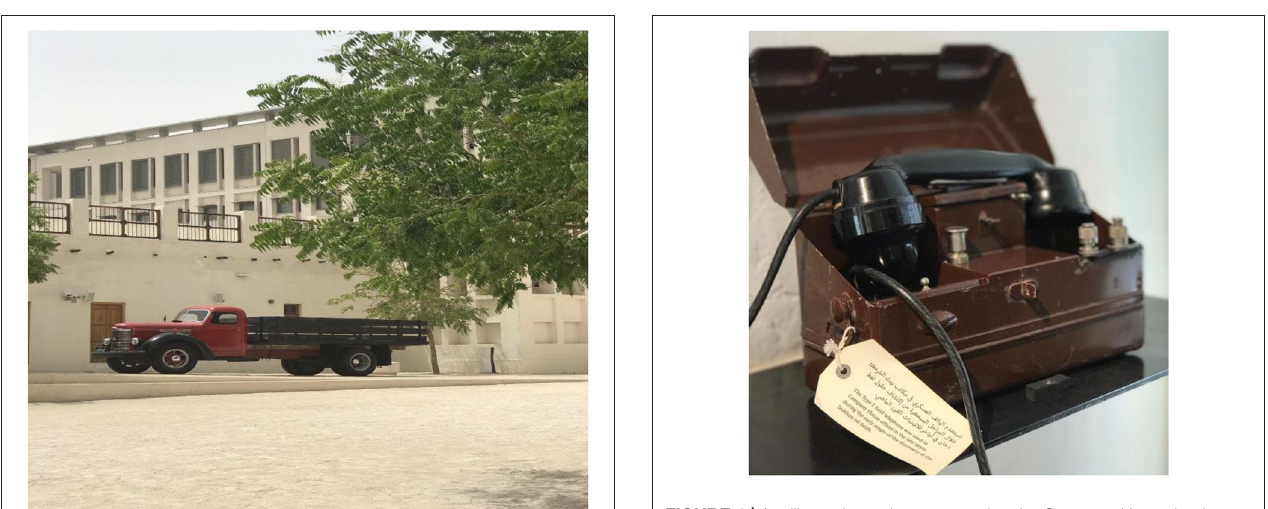
FIGURE 4 | A military phone that was used at the Company House by the British workers at the oil company.